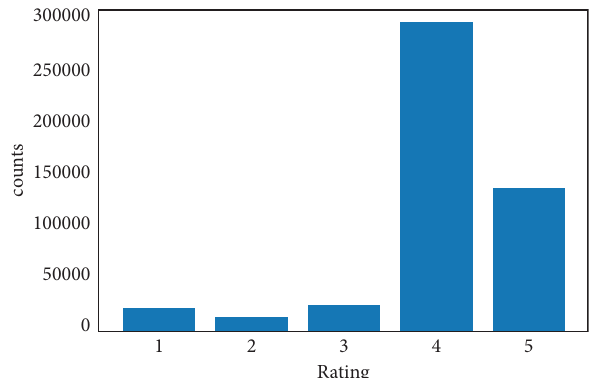
Figure 6: Te distribution of ratings after data